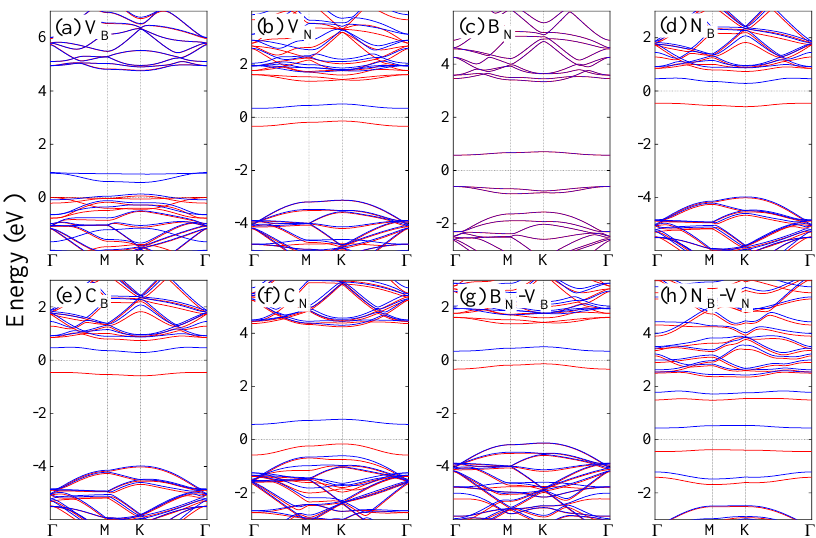
Figure 2. Spin-resolved electronic band structure of hBN monolayer with various defects of ( a ) V B ; ( b ) V N ; ( c ) B N; ( d ) N B ; ( e ) C B ; ( f ) C N ; ( g ) B N -V B ; and ( h ) N B -V N . The Fermi energy level is pinned to 0 eV. The red and blue lines indicate the spin-up and -down electronic band and energy levels. Figure 3 shows the spin-resolved electronic density of states (DOS) for the hBN monolayer with various defects. The vertical dashed line indicates the Fermi energy level, which is pinned to 0 eV. The abundant electronic DOS across the Fermi level were observed for the BN atomic layer with V B , C B , and N B -V N defects, which indicates the high conduction electronic characteristics. For the BN atomic layer with the B N defect, the spin up- and spin down-DOS overlapped each other, which led to zero spin-dipole magnetic moments. The atomic layer with defects of V N and B N -V B displayed a similar electronic band structure and DOS due to the structural instability with the B N -V B defect, where the boron substitution jumped to the neighboring vacancy position. The atomic layer with the B N -V B defect eventually transformed into an atomic layer with a V N -like defect during the structural optimization process. The BN-VB defect is unstable in the structure because a minimum total energy is required for the system to be stable. The defects of V B , V N , C N , B N -V B , and N B -V N in hBN induced the metallic characteristics. A point V B defect in a 4 × 4 unit cell offers a high defect density of 1.155 × 10 14 cm −2 . The strong doping with high defect density induces metallicity and shifts the Fermi level into the valence band. The metallicity with the defects of V N , C N , B N -V B , and N B -V N is attributable to the defect-induced large density of states around the Fermi energy level.